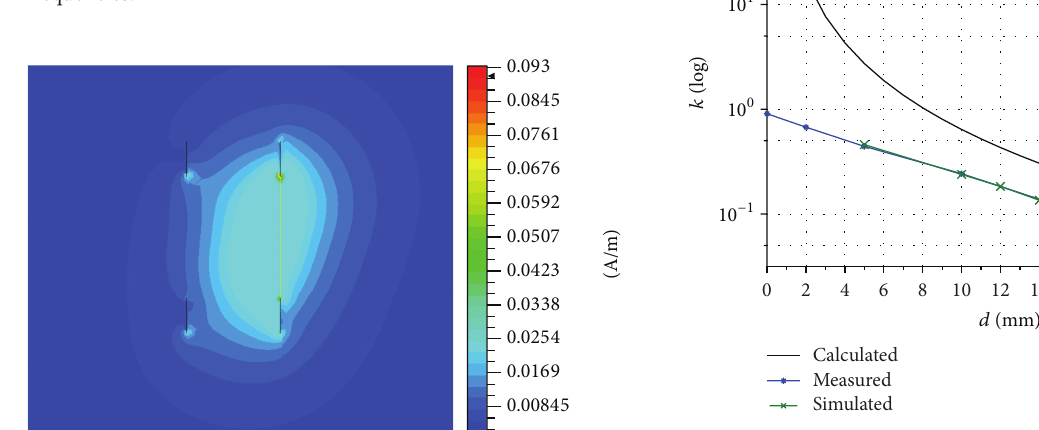
Figure 6: Coupling coefficient as a function of distance for different frequencies.